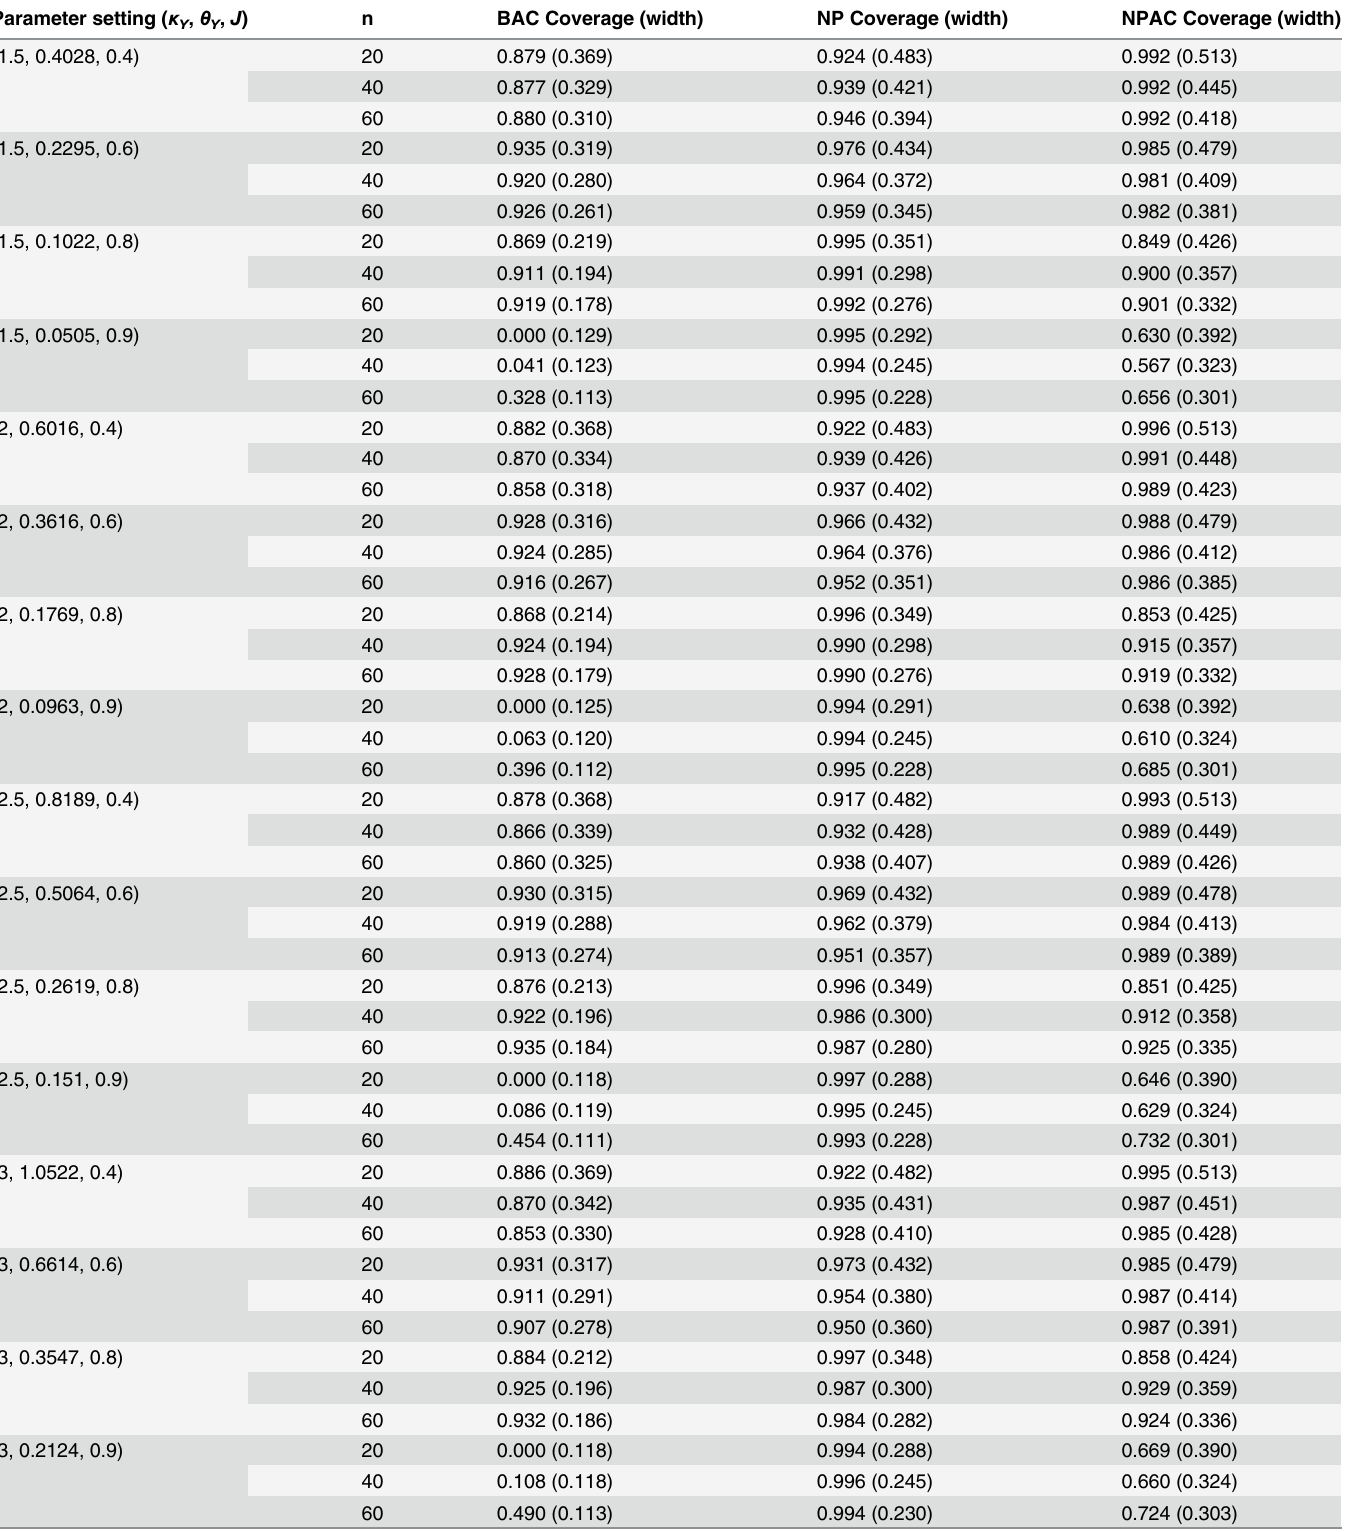
Table 5. Gamma distributions: coverage probabilities and average widths when m = 20 in the non-diseased group at the 95% nominal